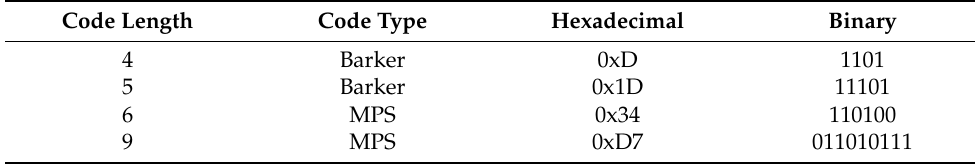
Table 3. Codes used in the experiment of WSAP waveform